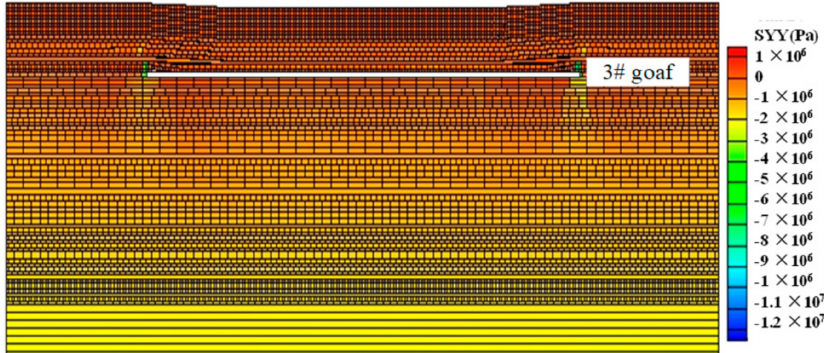
Figure 16. Stress field diagram of overburden after the mining of the 3# coal seam.